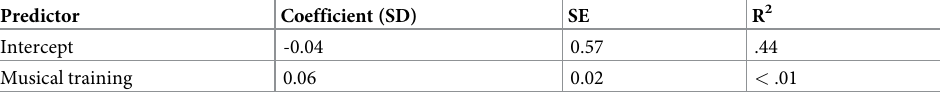
Table 4. Mixed effects multiple linear regression model for temporal envelope feature. Coefficients for each pre- dictor (and each degree of difficulty, as relevant) along with standard error (SE) and predictor R 2 are reported along with Pearson’s correlation, 95% CIs, p-value and R 2 for full models in the note below. Predictor Coefficient (SD) SE R 2 Intercept -0.04 0.57 .44 Musical training 0.06 0.02 < .01 Note. r = .69, CIs [.67, .72], p < .01, R 2 =